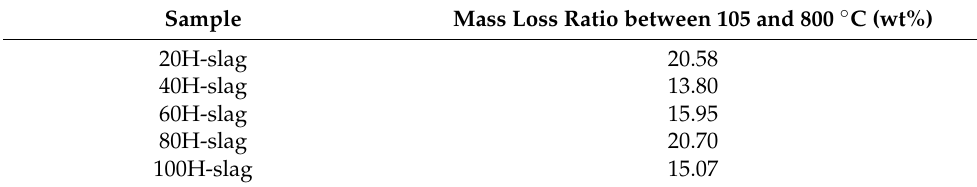
Figure 4. TG-DSC curves of the pretreated slags. Table 3. The mass loss ratio of the pretreated slags between 105 and 800 °C .